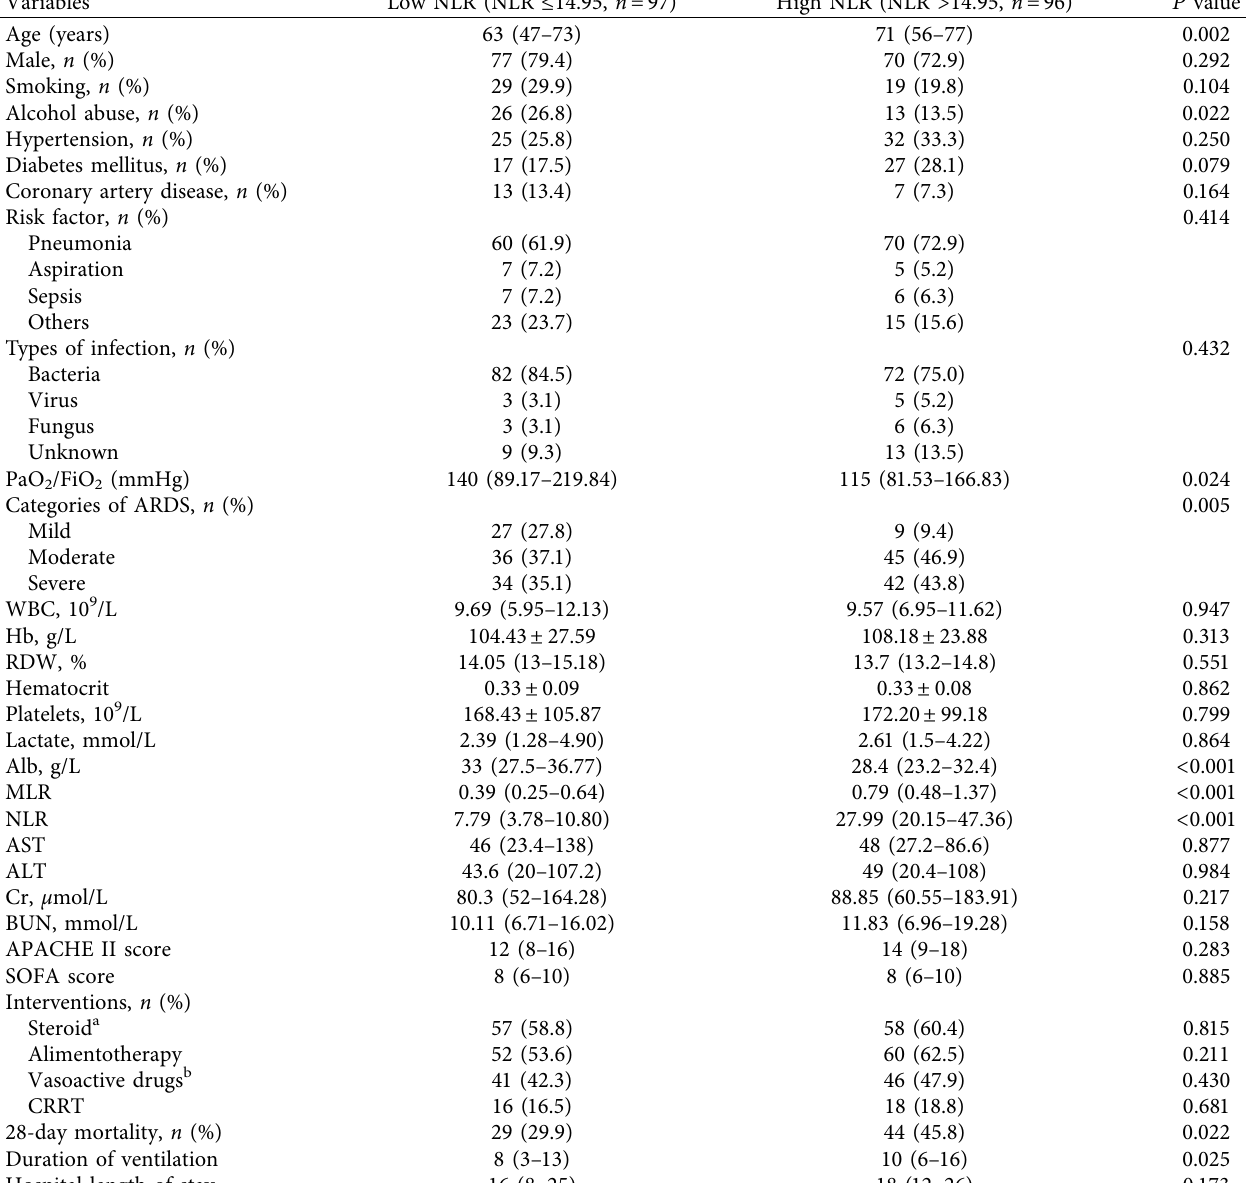
Table 5: Baseline characteristics of IMV group in different NLR